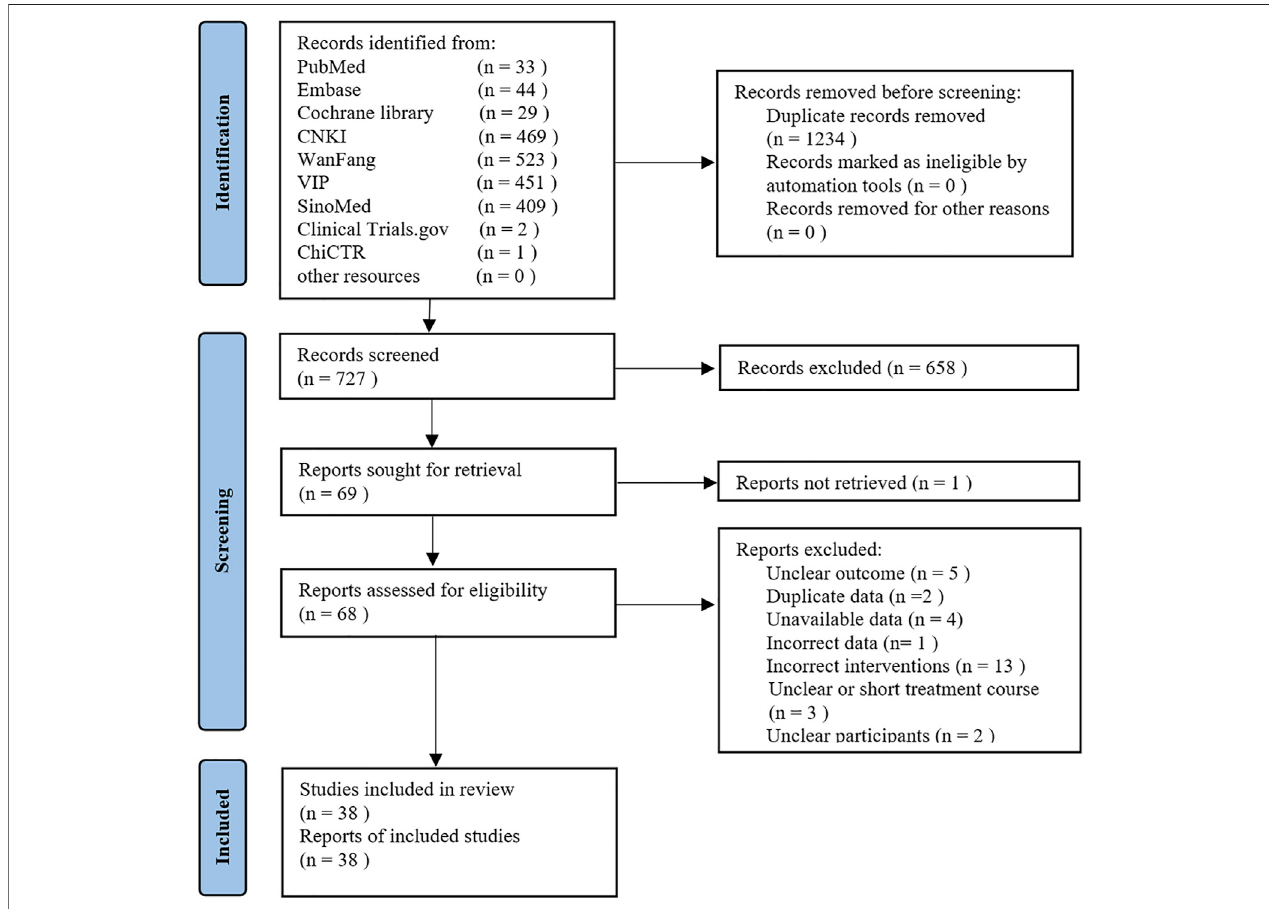
FIGURE 1 | Flow diagram for identi fi cation of